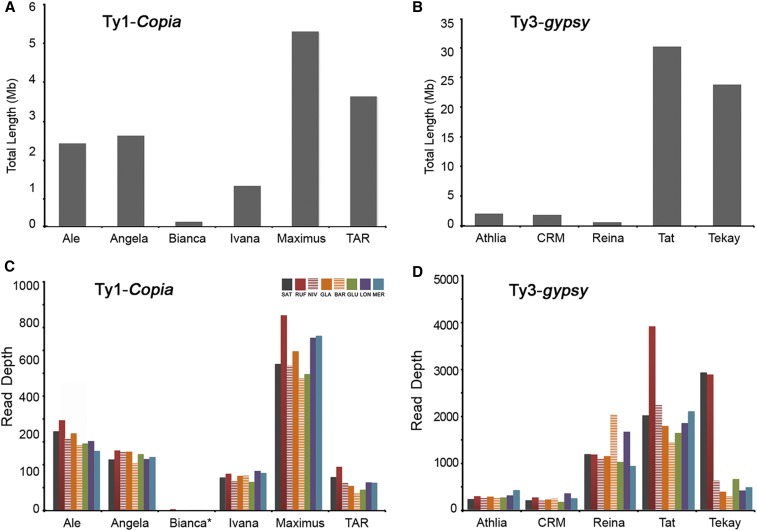
Sequence features of Ty1-copia and Ty3-gypsy retrotransposon families across the eight AA-genome Oryza species. Total sequence of Ty1-copia (A) and Ty3-gypsy (B) elements in the SAT genome, annotated using RepeatMasker. LTR reads depth proxy for copy number for various Ty1-copia (C) and Ty3-gypsy (D) families. LTR, long terminal repeat; SAT, O. sativa ssp. japonica. cv. Nipponbare (Release 7).